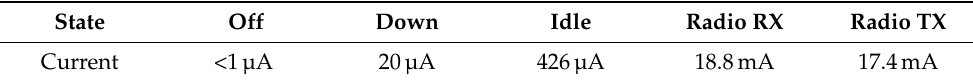
Table 6. Current consumption at different states of the Z1 mote